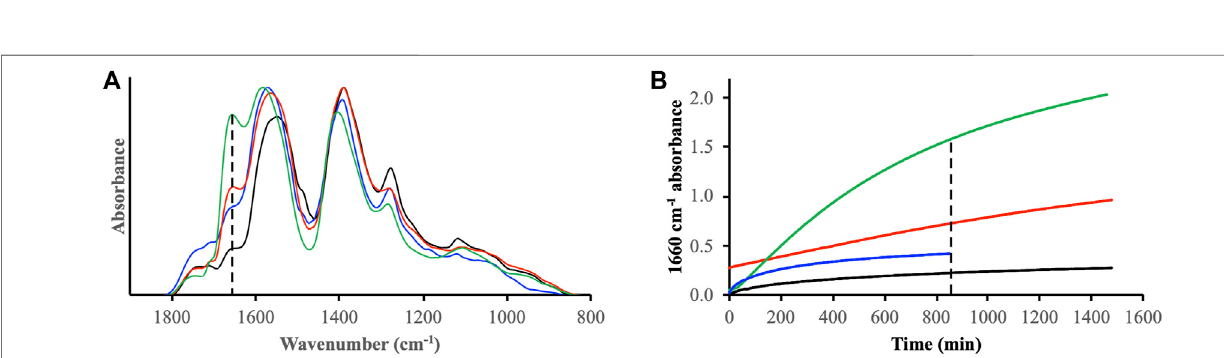
FIGURE 8 | (A) IR spectra of ferrihydrite reacted with DOM mod-EtOAc in the absence (black line) and presence (blue, red and green lines) of H 2 O 2 . The H 2 O 2 was added together with DOM mod-EtOAc (blue line), and to DOM mod-EtOAc -ferrihydrite suspension pre-equilibrated for 1 h (green line) or 24 h (red line). The IR spectra were collectedafterthesameexposuretimetoH 2 O 2 of850 min. (B) Thepeakintensityat1,660 cm − 1 isplottedasafunctionofexposuretimetoH 2 O 2 ;thecolor-codingofthe linesis the same asin (A) . To account for variations in the ferrihydrite fi lm thickness on the ATR crystal the spectra were normalized tothe samemaximum